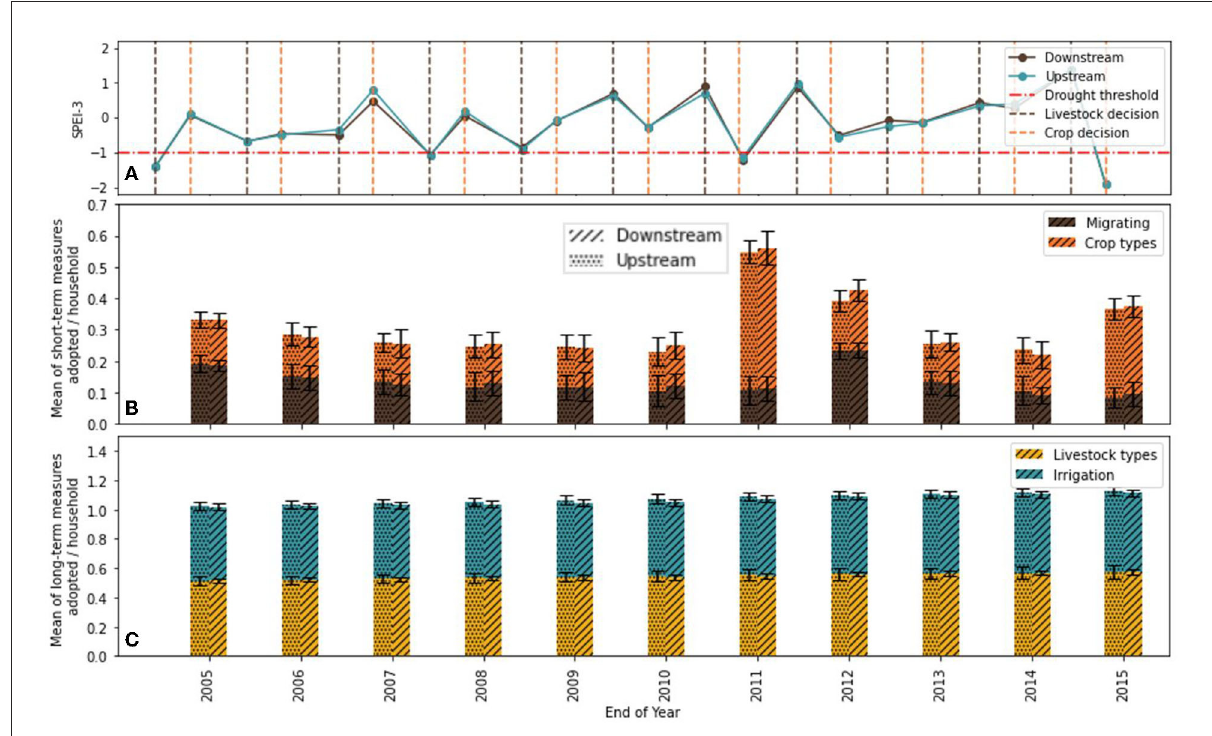
FIGURE4 SPEI-3 for livestock and crop decisions over time (A) . Mean of short and long-term adaptation measures adopted per household over time (B, C) . Striped bars indicate the average for downstream agents and the dotted bars the upstream agents. The error bars indicate the 5th and 95th confidence